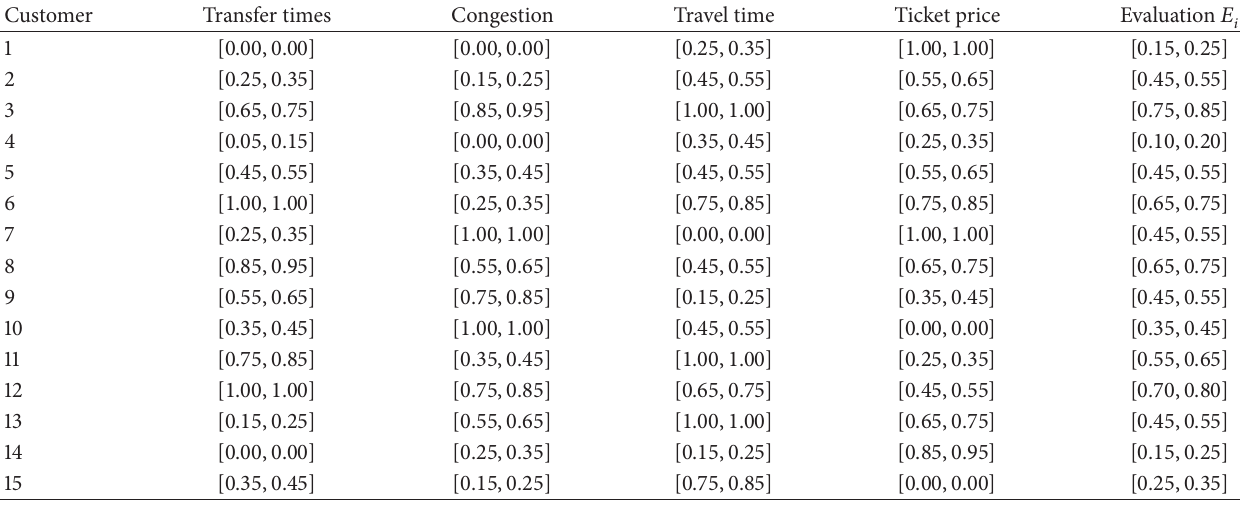
Table 7: Data of Example 22 (the customer evaluation).